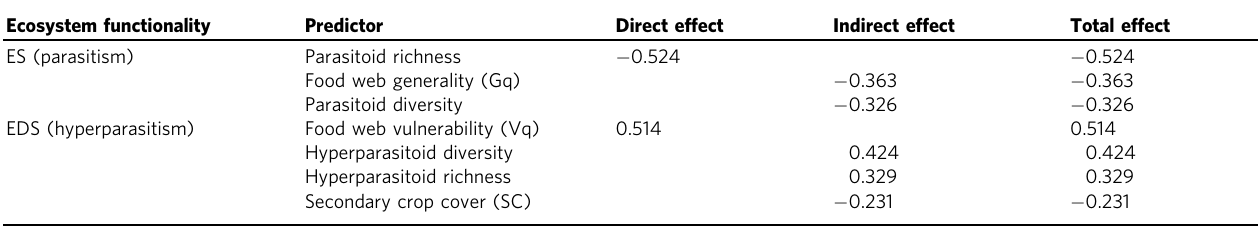
Table 2 Summarized effects of different predictors on ultimate ecosystem functionality. Ecosystem